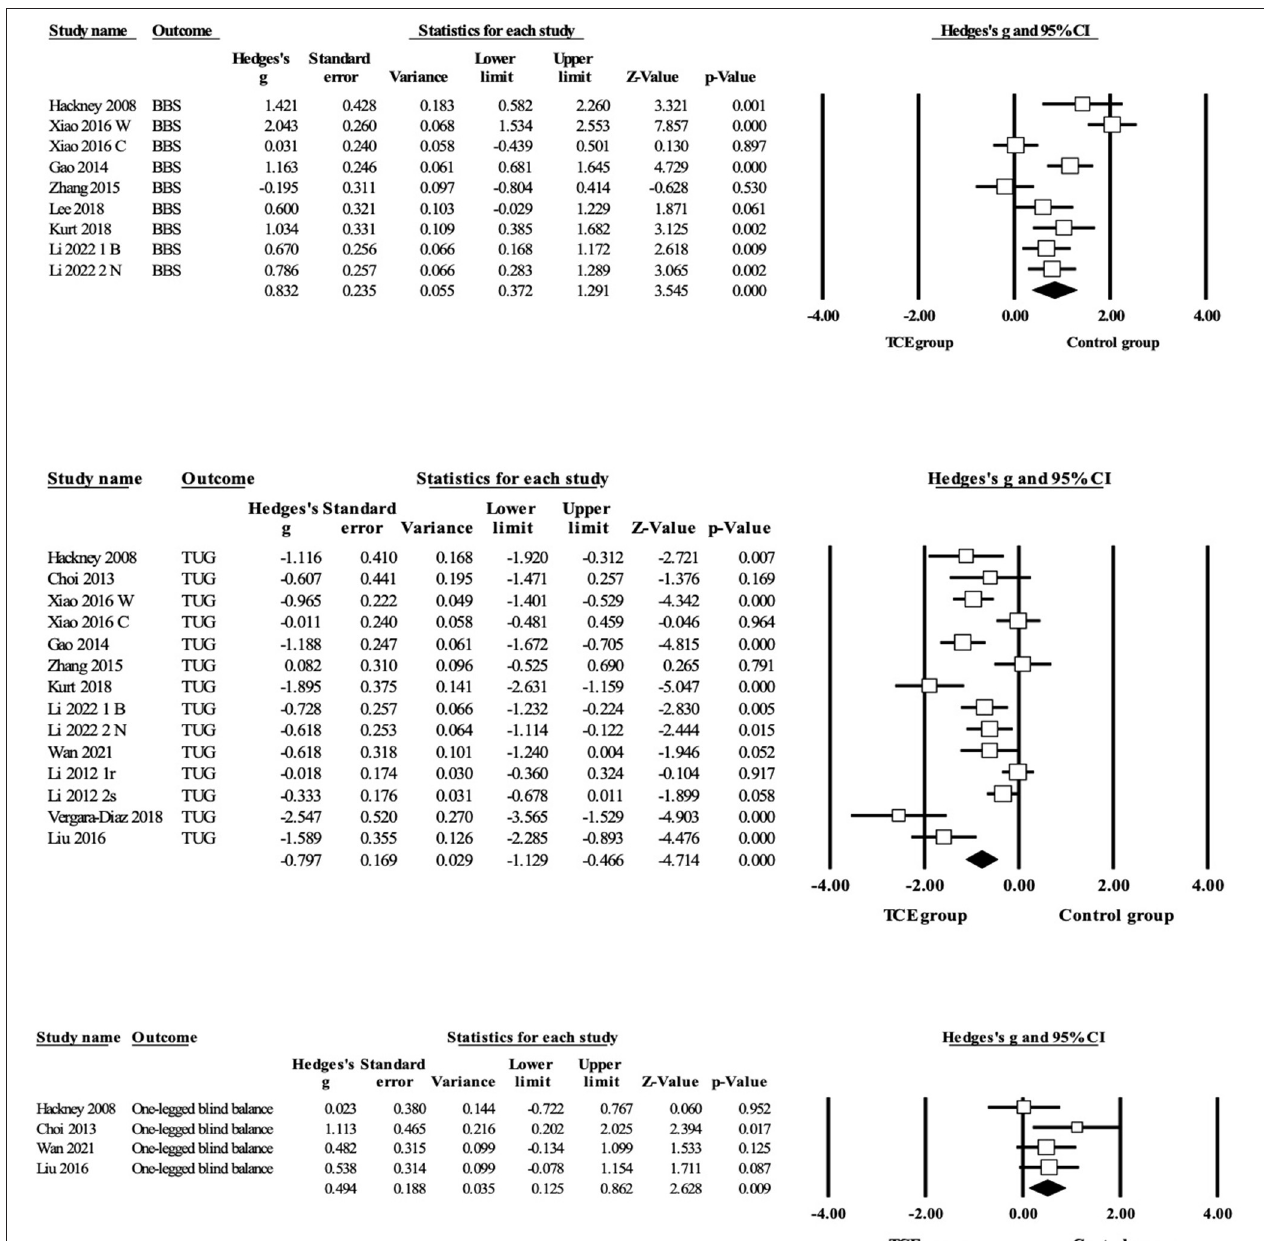
FIGURE 3 | Forest plot showing the effects of TCE vs. control group on BBS outcomes: BBS, TUG, one-legged blind balance.